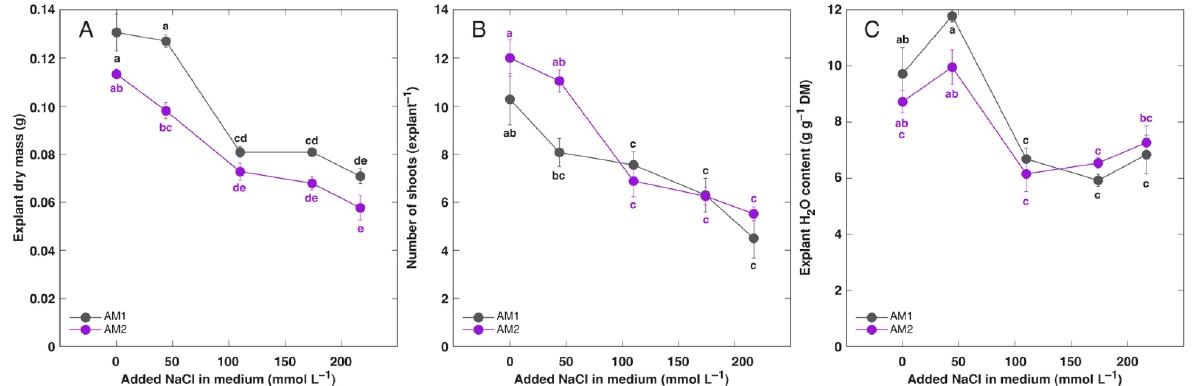
Figure 1. Effect of added Na concentration in tissue culture medium on dry mass ( A ), number of shoots ( B ) and tissue water content ( C ) of explants of Armeria maritima accessions AM1 and AM2 after 4 weeks of cultivation. Data are means ± SE from 5 replicates, with five explants each. Different letters of respective color between accessions and treatments indicate statistically significant differences ( p < 0.05).